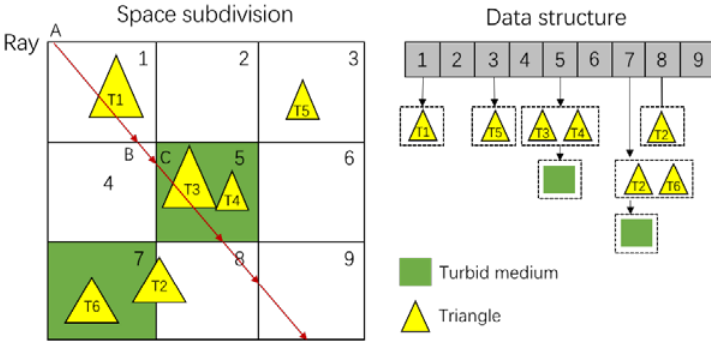
Figure 2. Space subdivision and data structure.